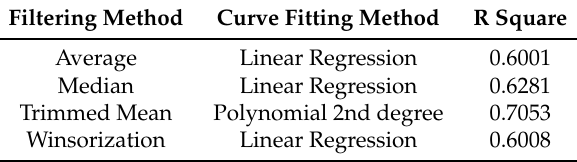
Table 1. RSSI to distance office band 2.